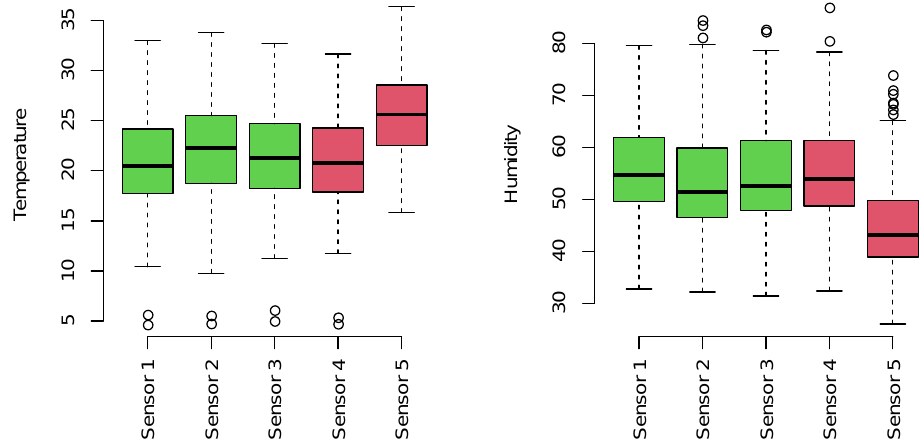
Figure 14. Clustering of SO 2 data for the full period of the study and their visualization with respect to temperature and humidity.